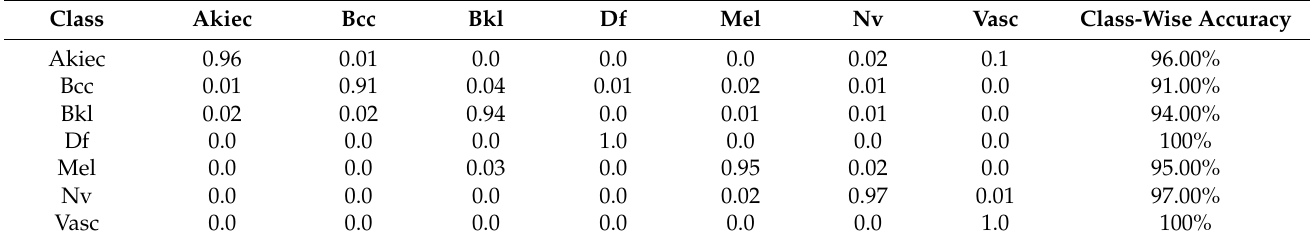
Table 3. Confusion matrix of the proposed model with the preprocessing